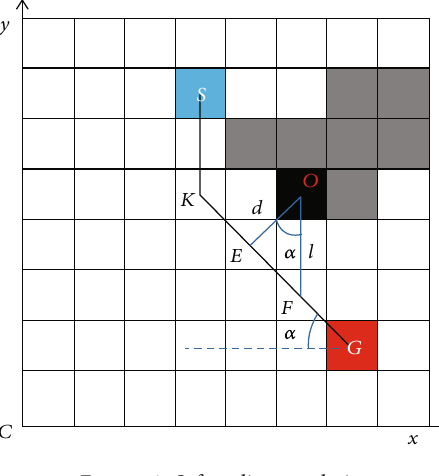
Figure 3: Safety distance design.